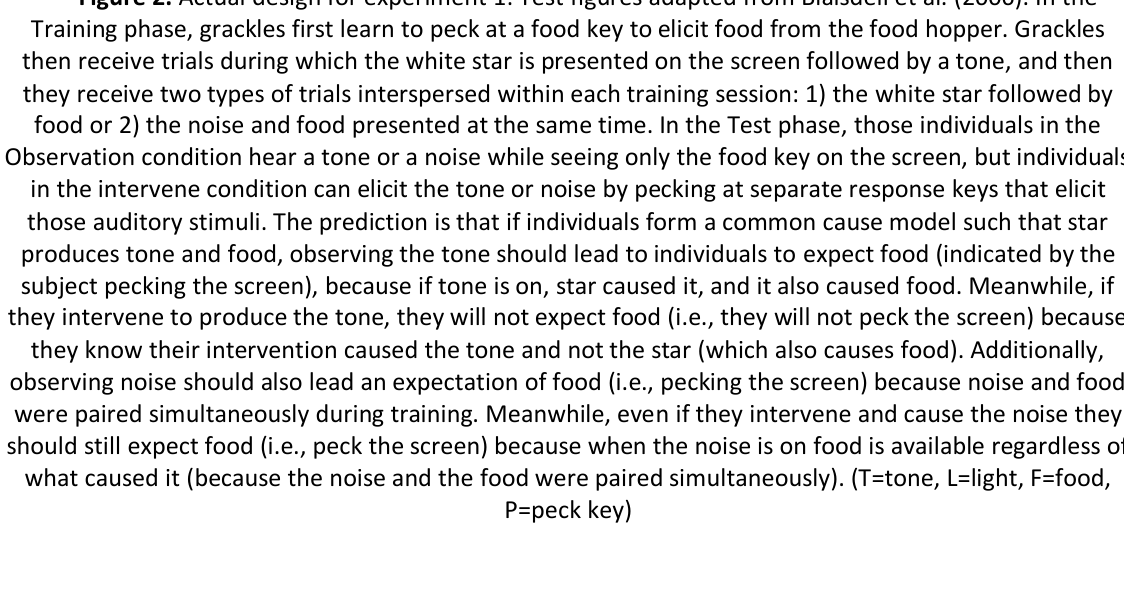
Figure 2. Actual design for experiment 1: Test figures adapted from Blaisdell et al. (2006). In